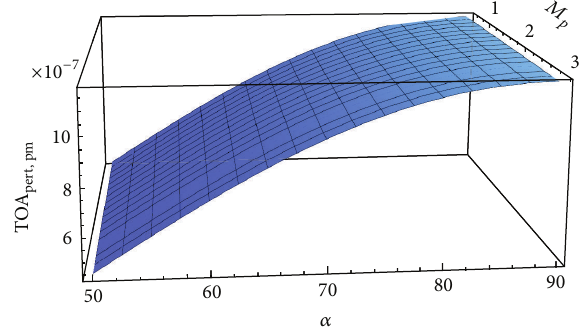
Figure 2: Values of TOA in seconds obtained from (13) for a pert , pm range of values of the planet mass 𝑀 𝑝 and moon orbit inclination 𝛼 . We have also chosen sin 𝐼 = 1 , 𝑅 = 5.2 AU, 𝑟 = 𝑅/40 , and 𝑀 𝑚 = /10 . 𝑀 𝑝